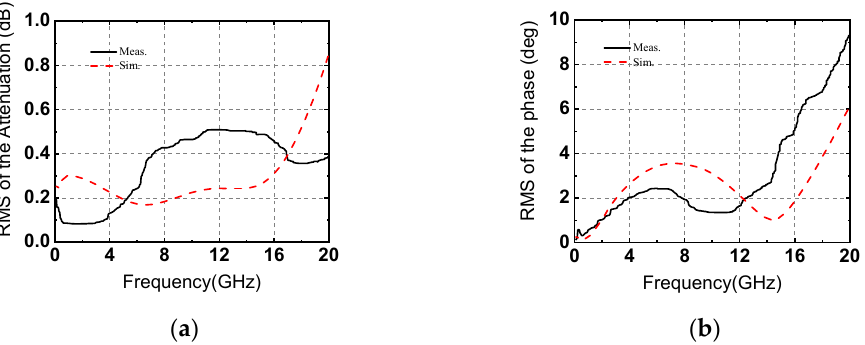
Figure 10. ( a ) Measurement and simulation results of the attenuation RMS error. ( b ) RMS error of the insertion phase shift. Table 1. Performance comparison of the attenuator circuits.